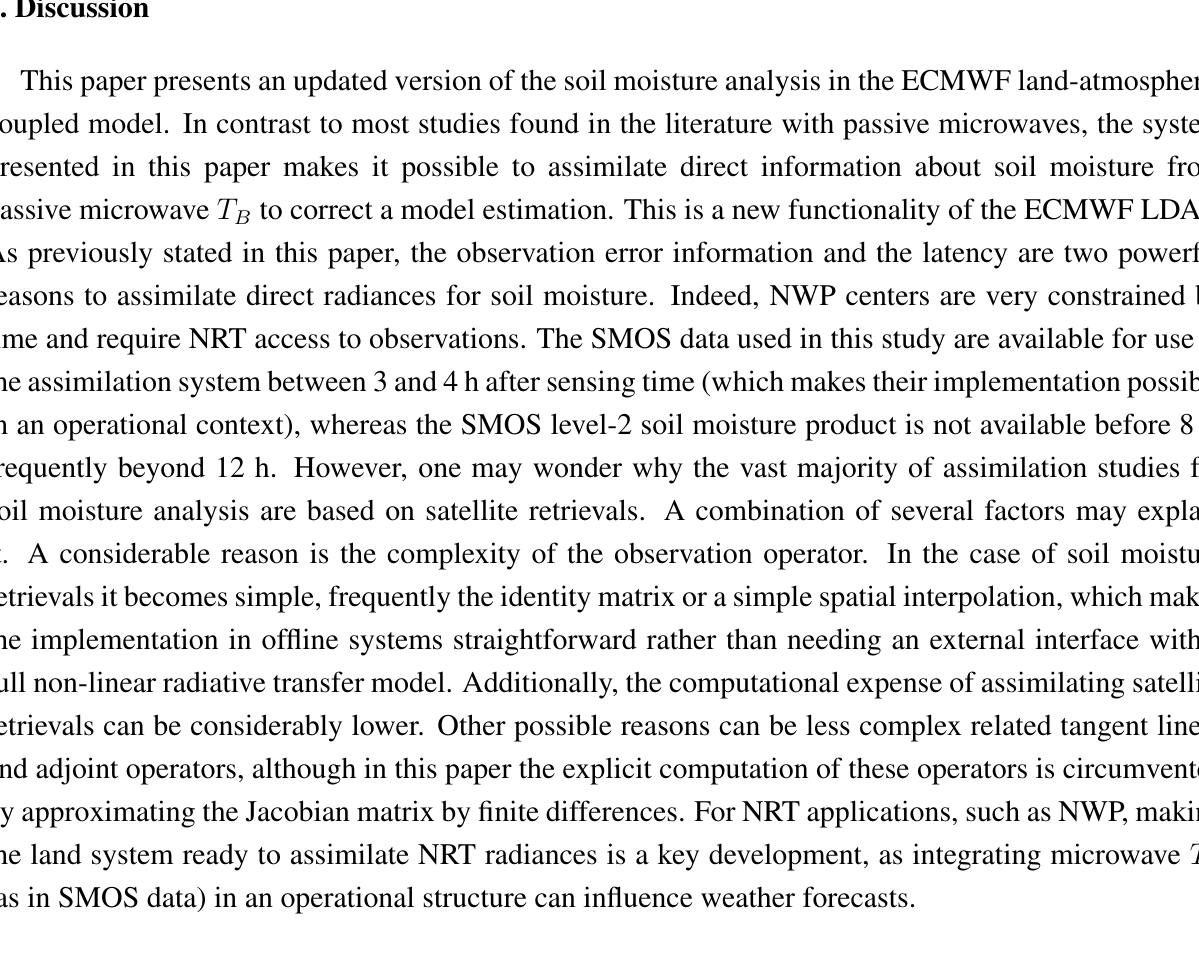
Figure 12. Averaged forecast biases for 12 h, 24 h, 36 h and 48 h T data from SYNOP stations. Forecast bias is defined as (observation-forecast). The period of forecasts starts on 1 July and ends on 15 July 2012. The forecast base time is 00UTC. The geographical coordinates of the Great Plains region are defined as (N = 50, W = (cid:0) 110, S = 33, E = (cid:0) 93), and for the northern region of Europe: (N = 75, W = 0, S = 52, E =